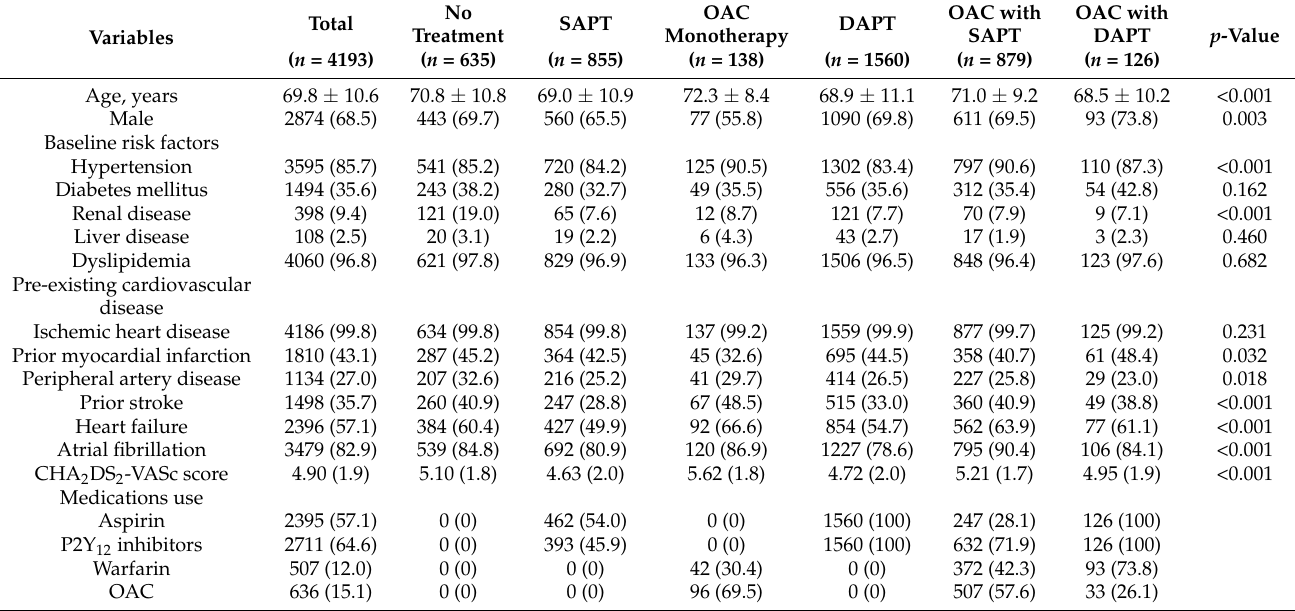
Table 1. Baseline characteristics of the total study population based on combinations of anticoagulants and antiplatelet agents.